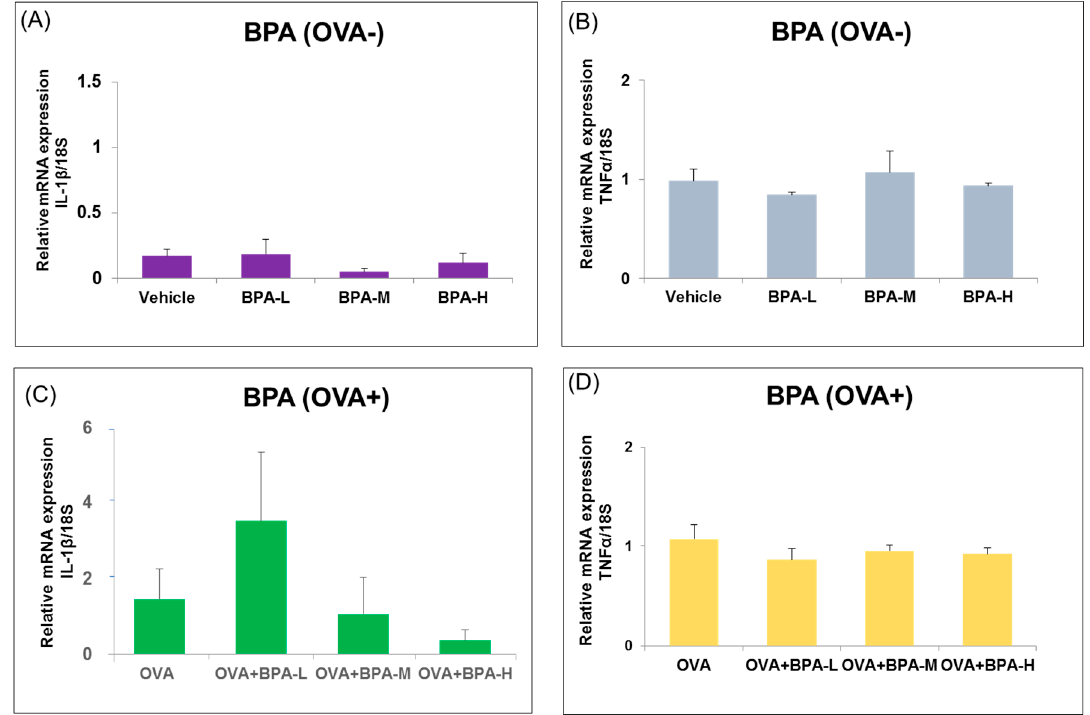
Figure 5. Expression level of inflammatory cytokines (IL-1 β and TNF- α ) in the hypothalamus of male mice exposed t to BPA without OVA ( A and B ) and with OVA ( C and D ). Each bar represents the mean + SE ( n = 5~6). Int. J. Environ. Res. Public Health 2018 , 15 , x